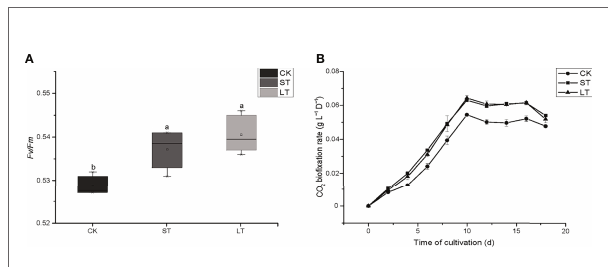
FIGURE 2 | The Fv/Fm (A) and CO 2 biofixation rate (B) of N. oceanica when subjected to different treatment conditions. The error bars represent the standard deviation (SD), n = 3. Different letters represent significant differences at p < 0.05. CK, control; ST, short-term acidification; LT, long-term